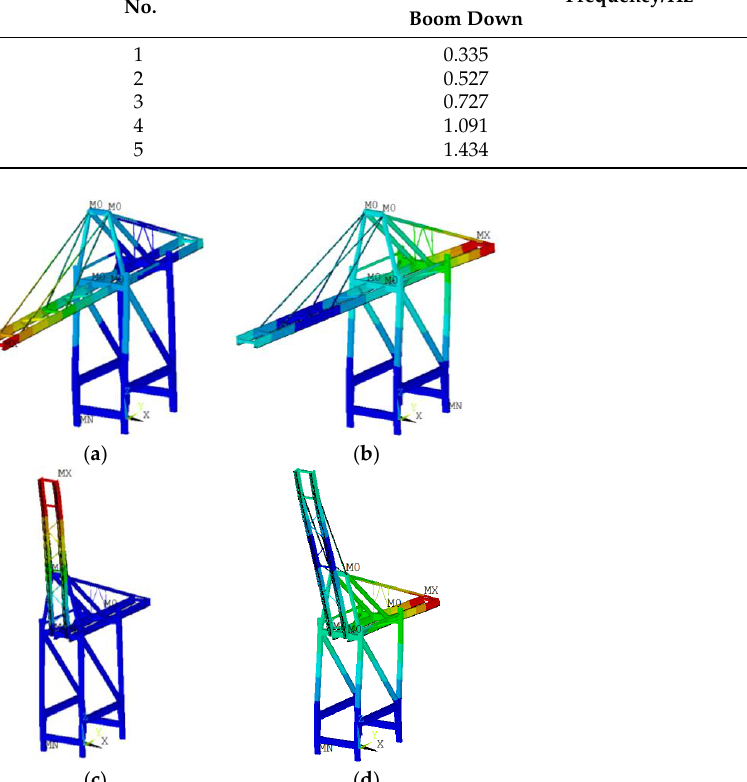
Figure 17. Modal shapes for the FEM model: ( a ) 1st mode of boom-down crane; ( b ) 2nd mode of boom-down crane; ( c ) 1st mode of boom-up crane; and ( d ) 2nd mode of boom-up crane.